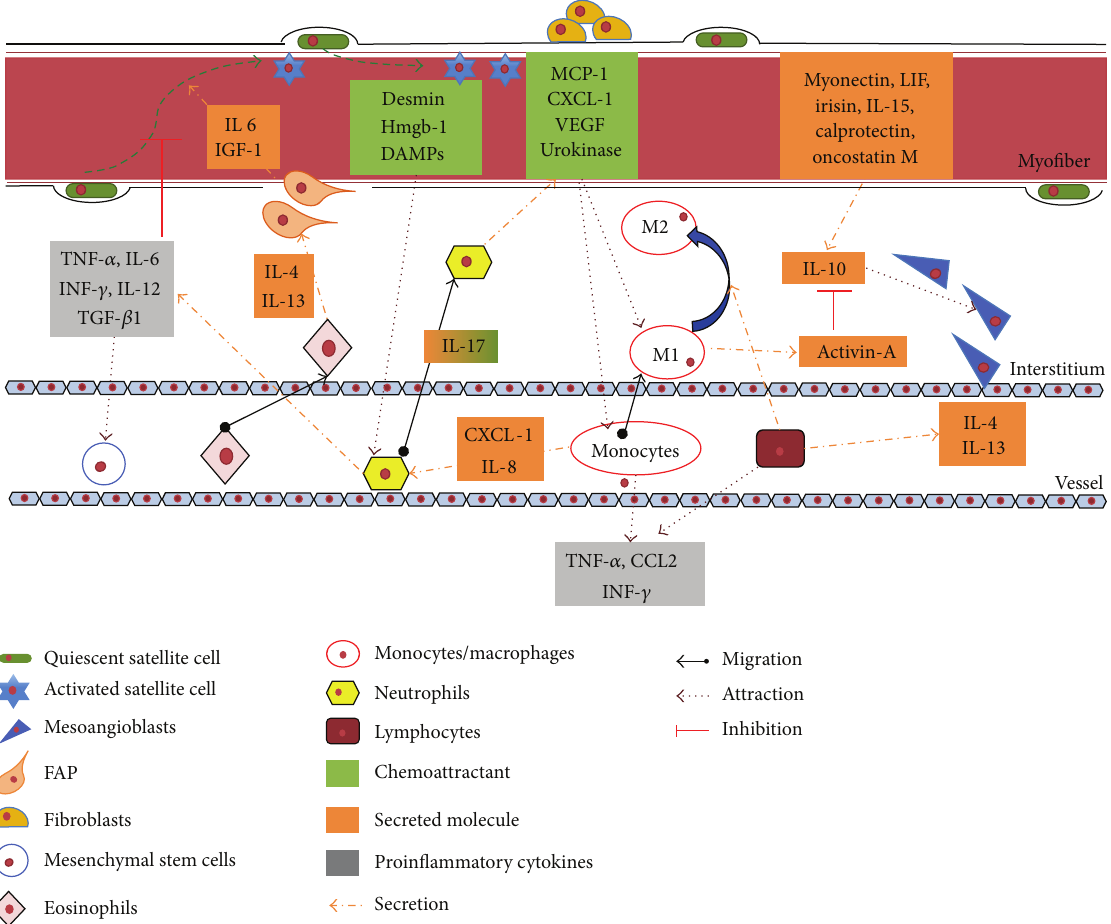
from M2 cells [122]. Suppression of p38 MAPK signaling is usually followed by Th2 cytokine elevation (IL-10 and TGF- 𝛽 ), suggesting the switch in macrophage phenotype during skeletal muscles regeneration